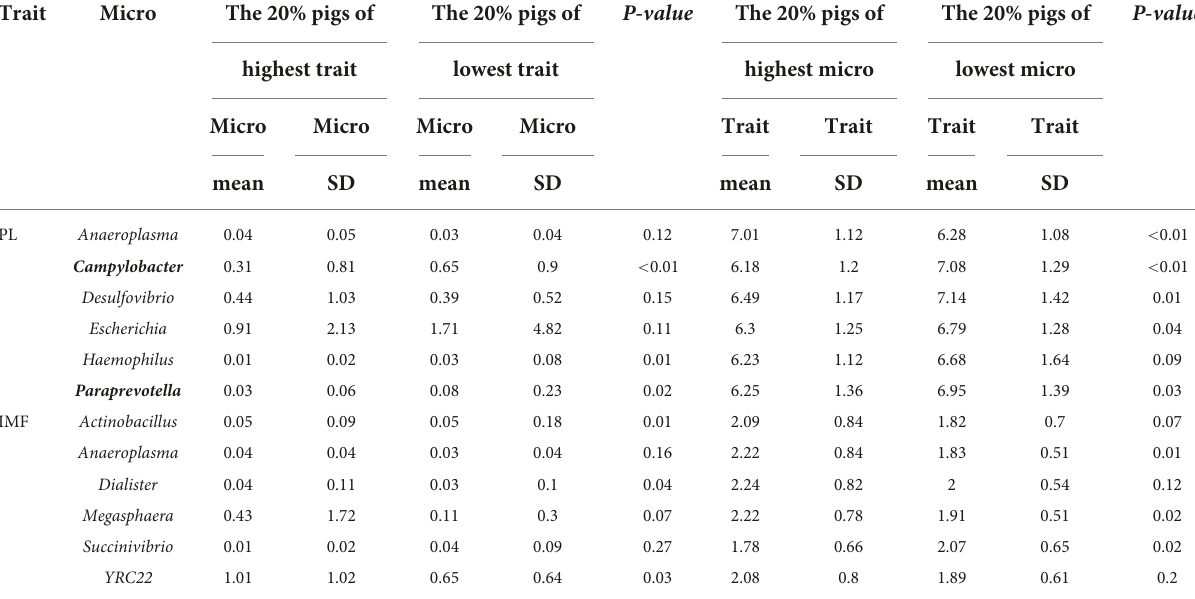
TABLE 4 Microbiome relative abundance and trait Wilcoxon test of highest 20% and lowest 20% groups in the resource population.